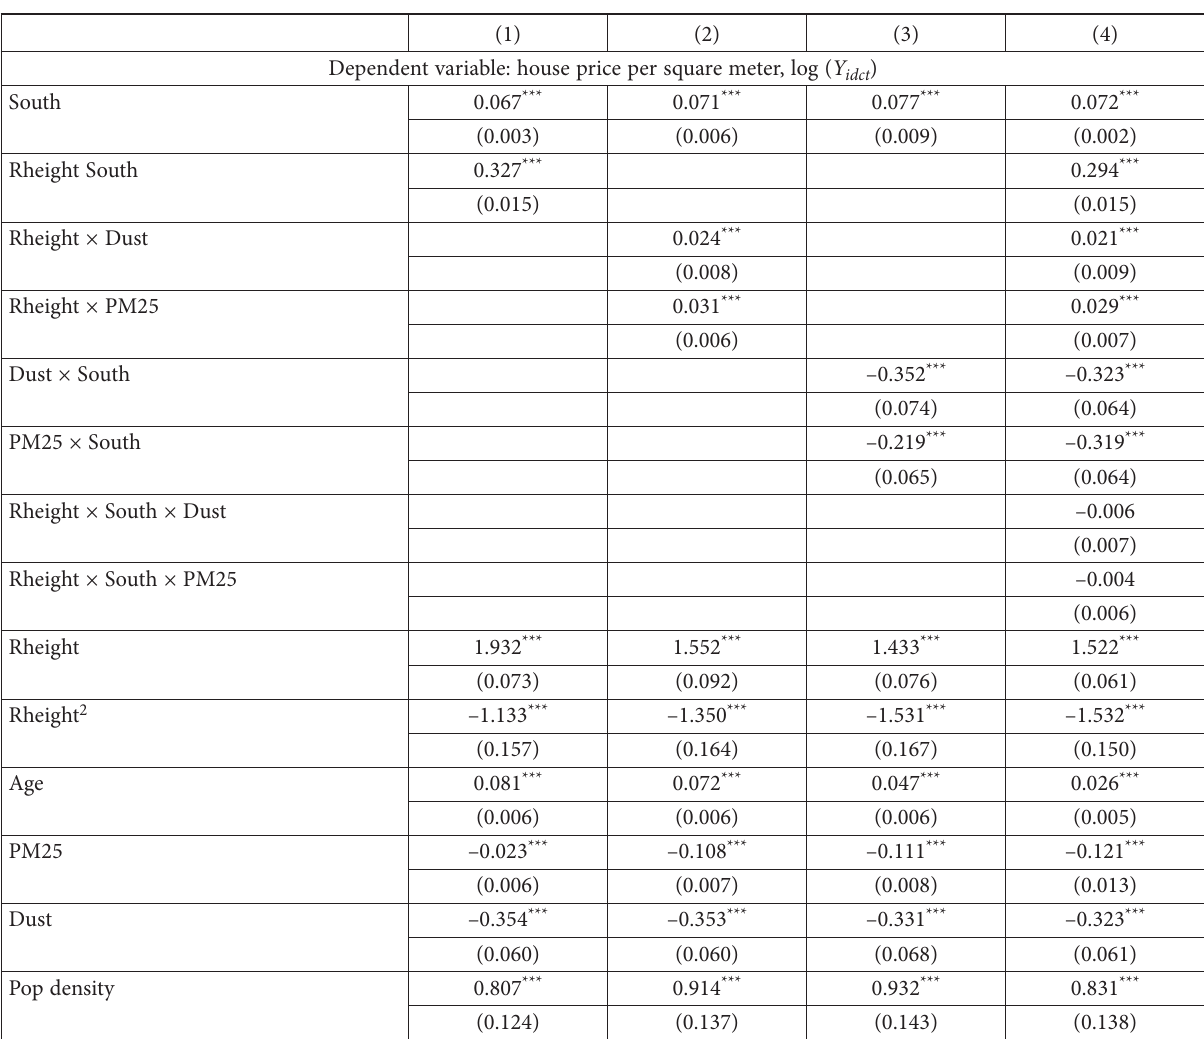
Table A2. The complete regression results of the extended model